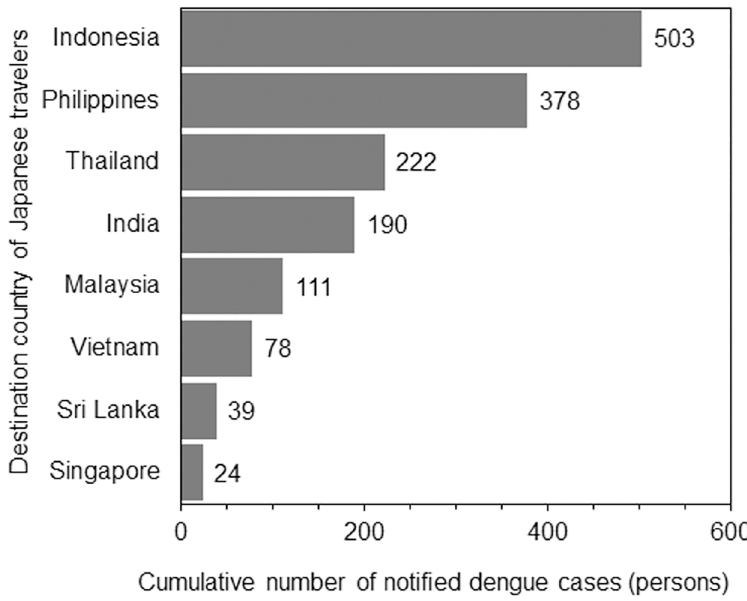
Fig 2. Cumulative number of imported cases of dengue virus infection from 2006 to 2016 by destination country. Eight countries are shown in descending order of cumulative number of cases. Only notified cases based on laboratory diagnosis are